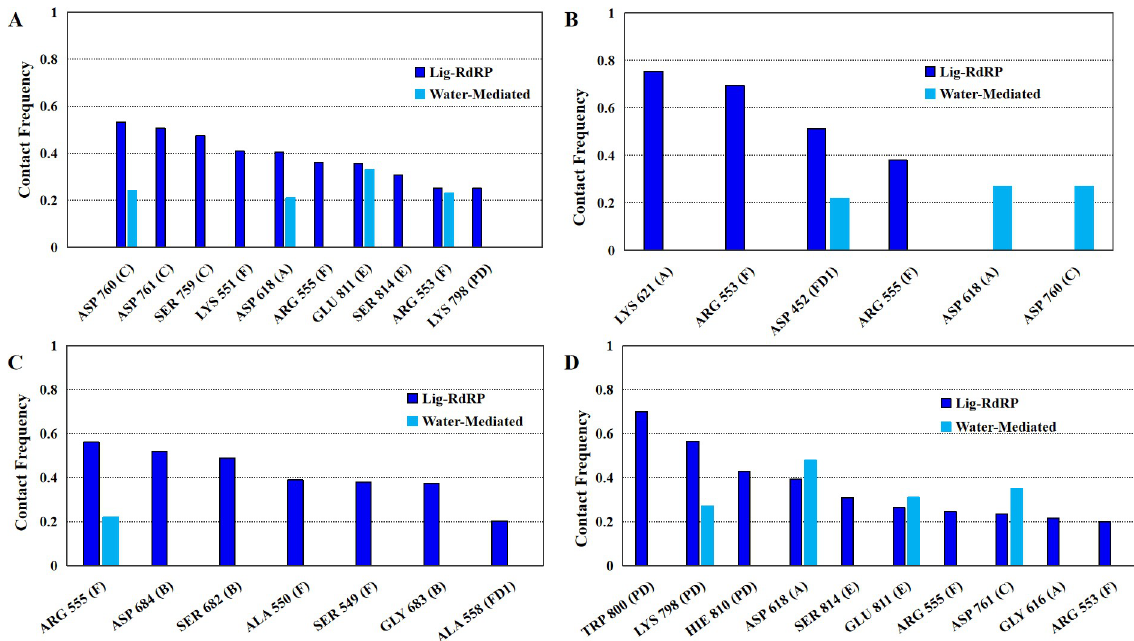
Fig 4. Stable interactions formed by the phytochemicals. Contact frequency of the hydrogen-bond and water mediated interactions between the RdRP residues and (A) SWE, (B) AMR, (C) SIT and (D) COR.